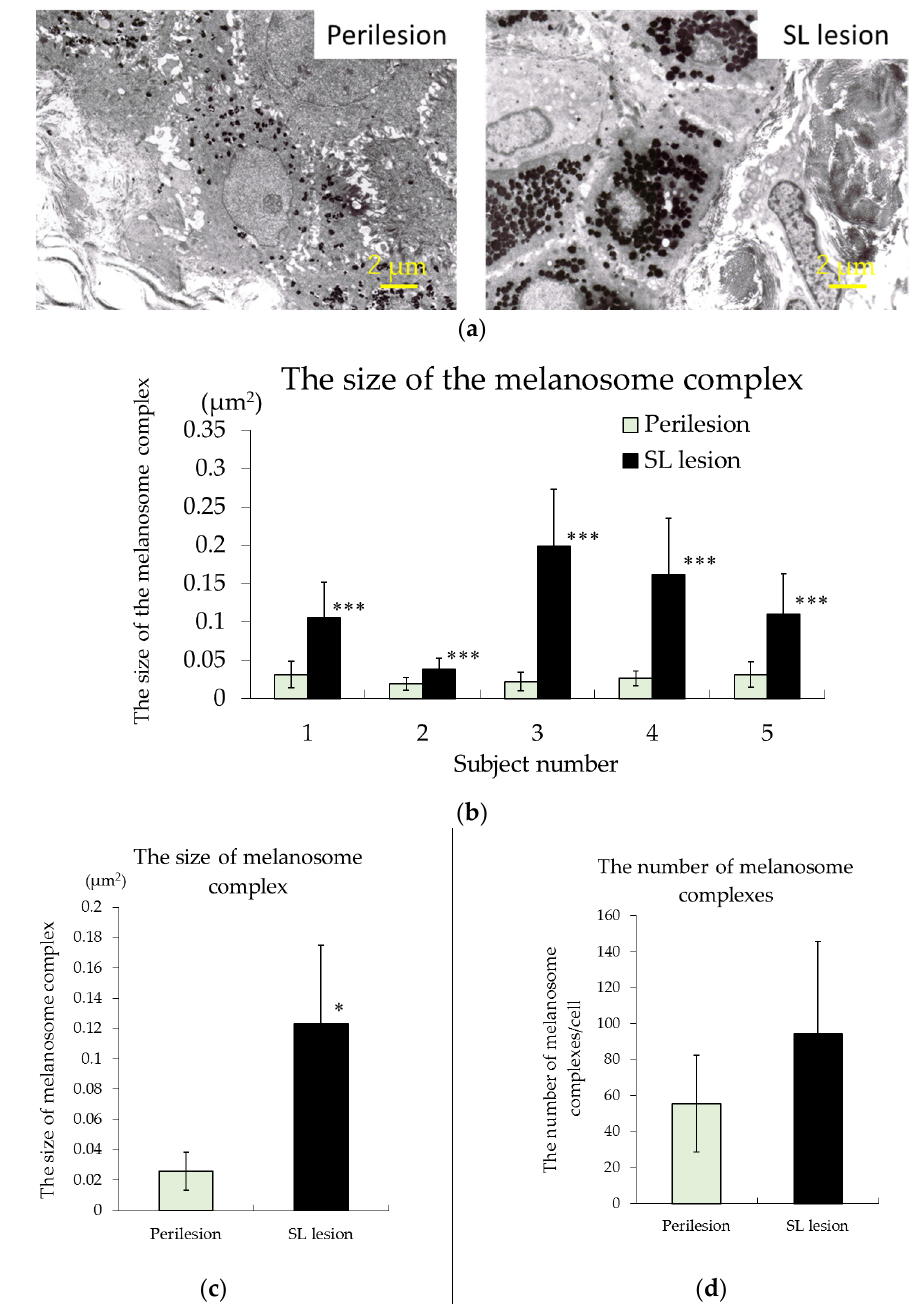
Figure 2. Representative electron micrographs (2700×) of biopsy samples of SL lesion and perilesional normal skin (( a ), subject #4). The size of the melanosome complex (( b ), individual; ( c ), mean) and the number of melanosome complexes (( d ), mean) in the keratinocytes of the basal layer of the epidermis in the perilesion and SL lesion samples. The results are expressed as the mean ± standard deviation of five subjects. ∗∗∗ p < 0.001 vs. the perilesion of each subject by a paired t -test, ∗ p < 0.05 vs. the perilesion according to an unpaired t -test.